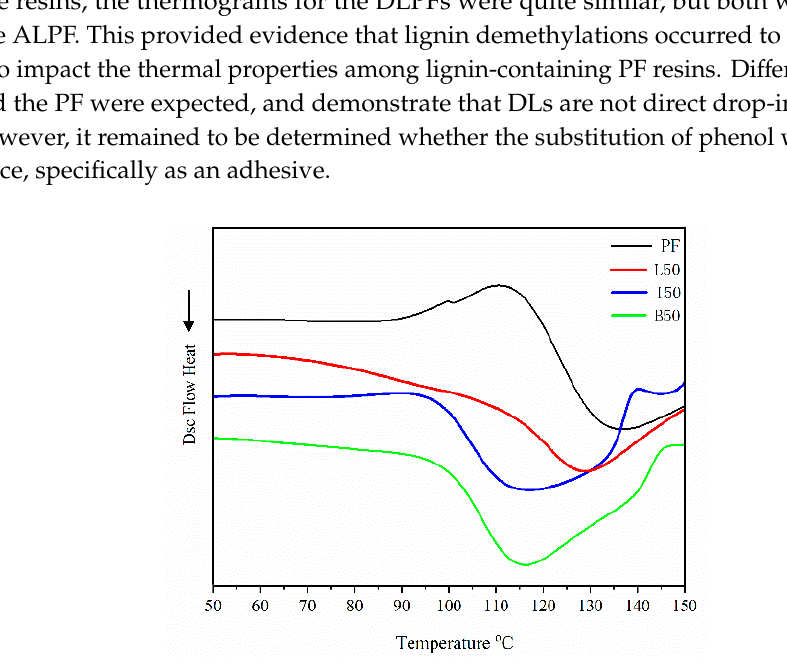
Figure 7. DSC analysis of PF, ALPF(L50), DLPF (I50, B50) resins with 50% lignin substitution. Table 5. Thermal properties of PF, ALPF and DLPF resins at 50% lignin substitution. DSC Analysis and Endothermic Event Resin